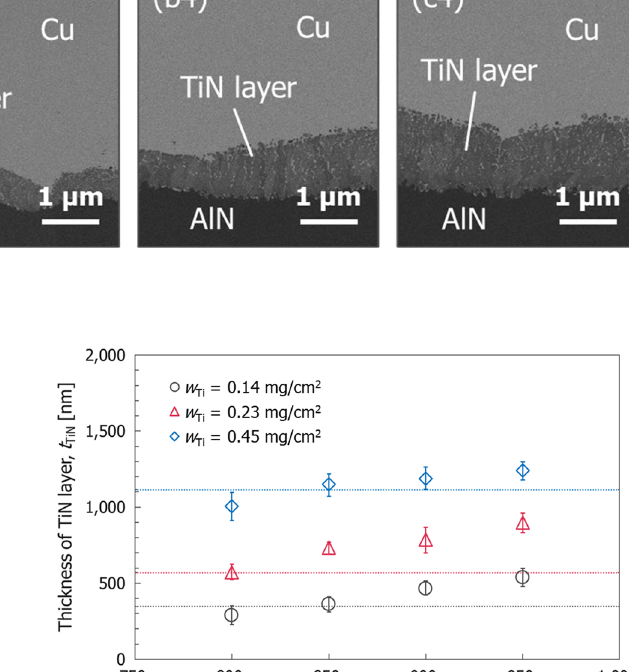
Fig. 3 Collection of cross-sec- tional EsB images of the Cu/ AlN interface bonded for 0.5 h between 800 °C and 950 °C with w Mg = 1.04 mg/cm 2 and w Ti = (a1−4) 0.14 mg/cm (b1−4) 0.23 mg/cm 2 , (c1−4)